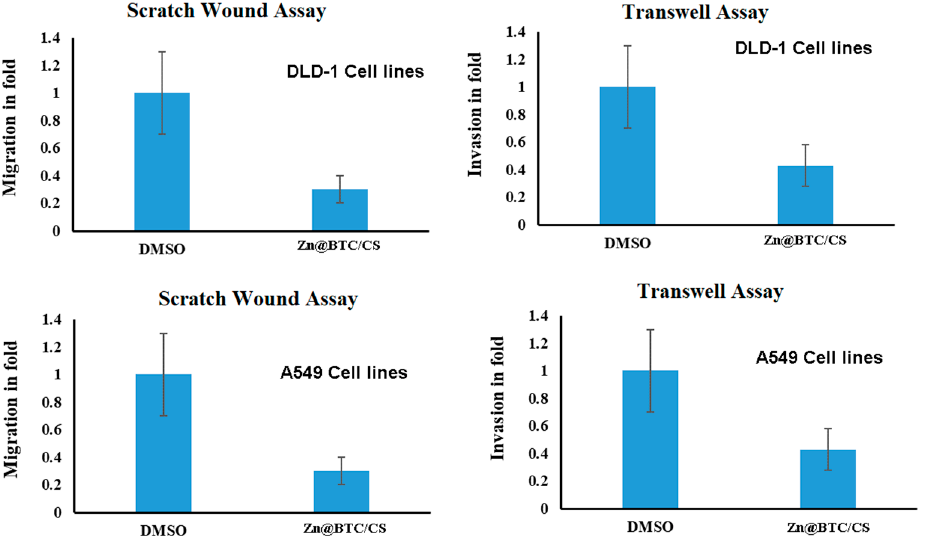
Figure 8. Anti-invasive and -migrative effects of Zn-BTC@CS on lung and colon cancer cell